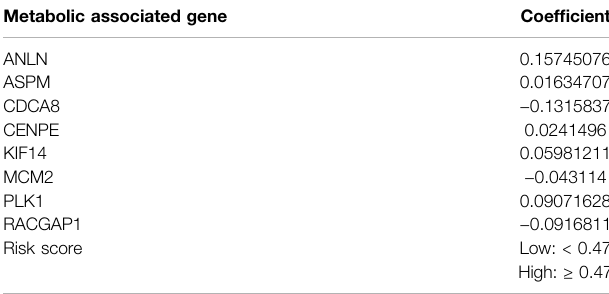
TABLE1| Twelvehypoxia-associatedgenesandcorrespondingcoef fi cientvalue. Metabolic associated